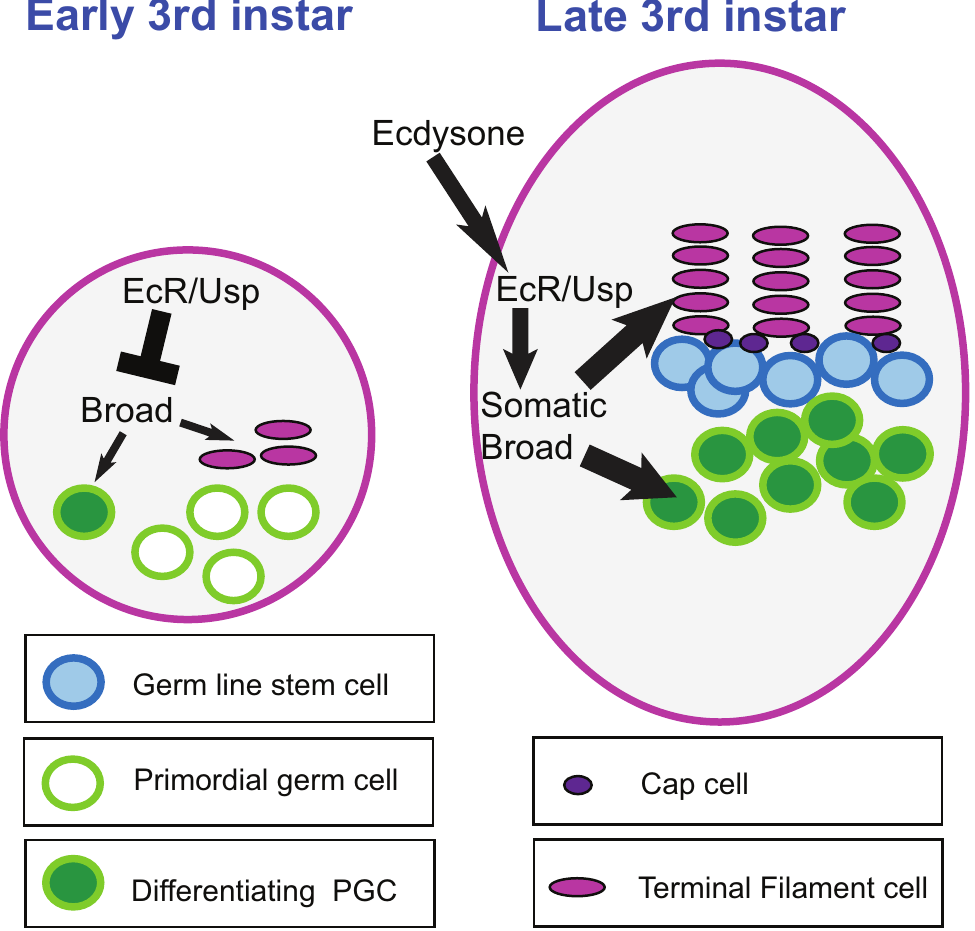
Figure 8. Coordination of niche formation with GSC establishment by ecdysone. At early third instar, ecdysone receptors repress niche formation and PGC differentiation; this allows the gonad time to grow and generate sufficient precursor cells of both cell populations that will eventually form 16–20 stem cell units. Repression of the target gene broad is a key component of this repression. At mid-third instar and later, the hormone ecdysone activates Broad-Z1 expression in the somatic cells of the ovary through EcR and Usp. This leads first to formation of niches and, later, concomitant with wandering behavior, to PGC differentiation, by an unknown mechanism. Only PGCs that are located next to niches are protected from differentiation and become the adult